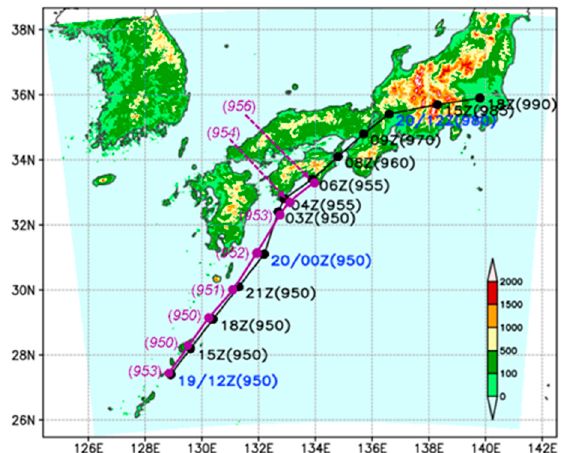
Figure 4. The domain (light-blue shaded area) and topography (m, shading, scale inserted) in the CReSS model, the JMA best-track data of TY0423 every 3 h over the simulation period of 19–20 October 2004 (black line with solid dots, date labelled and in blue every 12 h), and the simulated track at the same times until 0600 UTC 20 Oct (purple line with dots). Numbers in the parentheses give the estimated central MSLP (hPa) of TY0423 in the best-track data and model simulation.